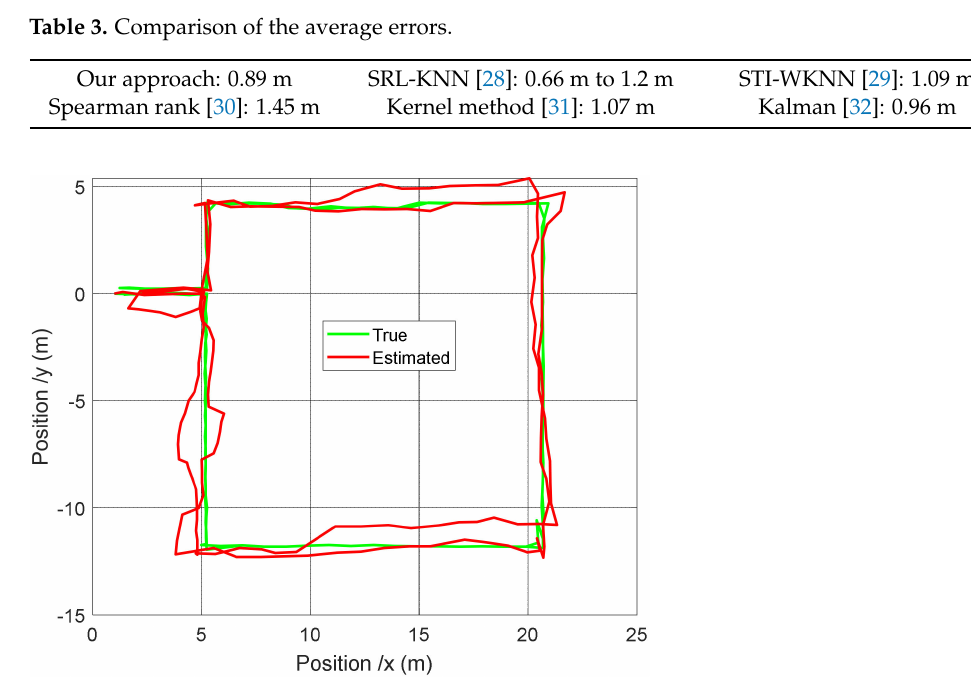
Figure 9. Real (ground truth) trajectory and the estimated one with our